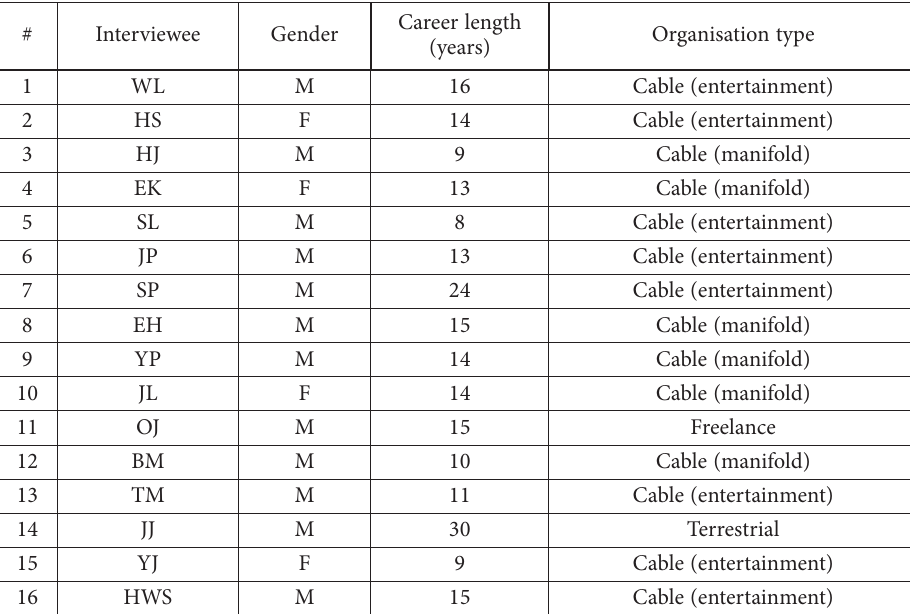
Table 1. Interviewee list (source: created by